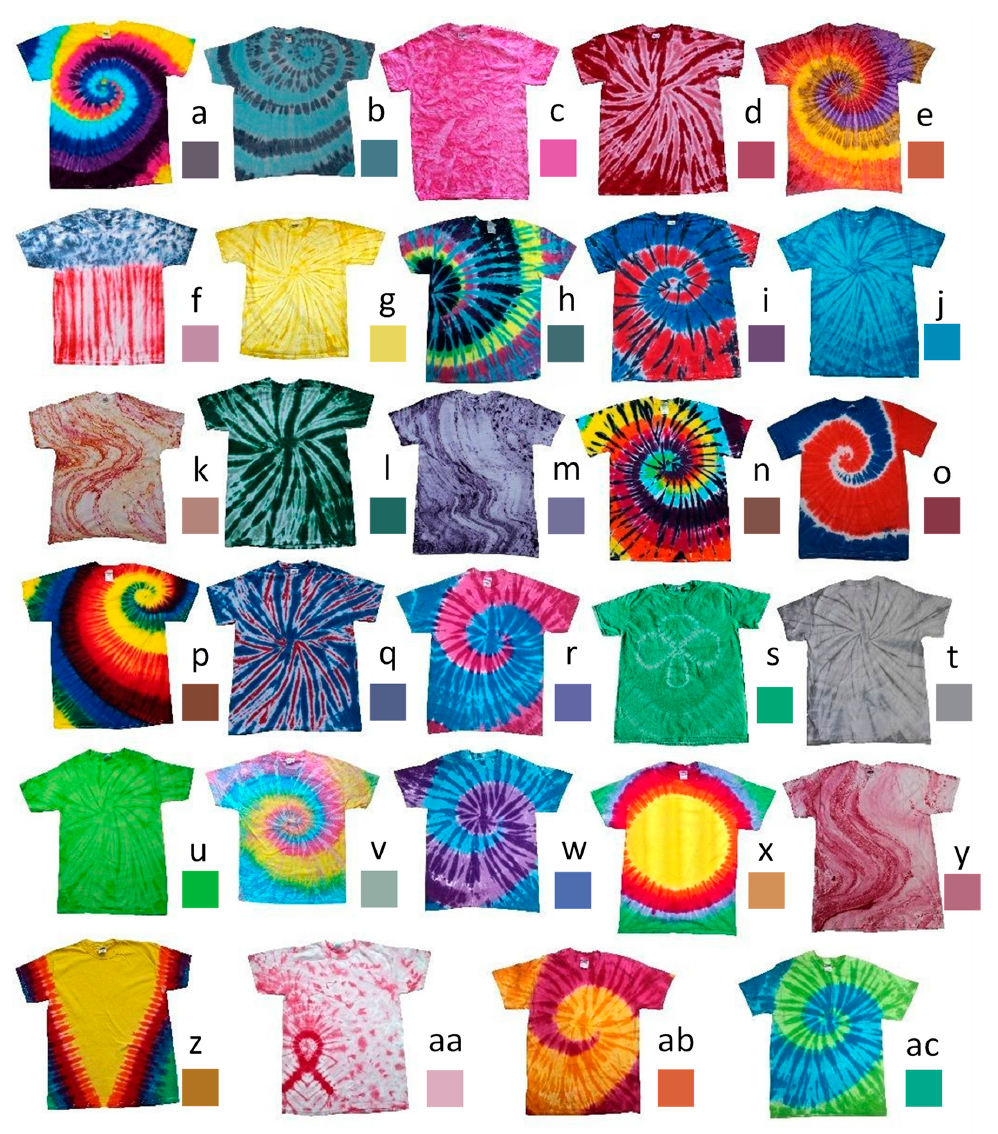
Figure 6. Twenty-nine dyed T-shirt images and their corresponding averaged color ( a – ac